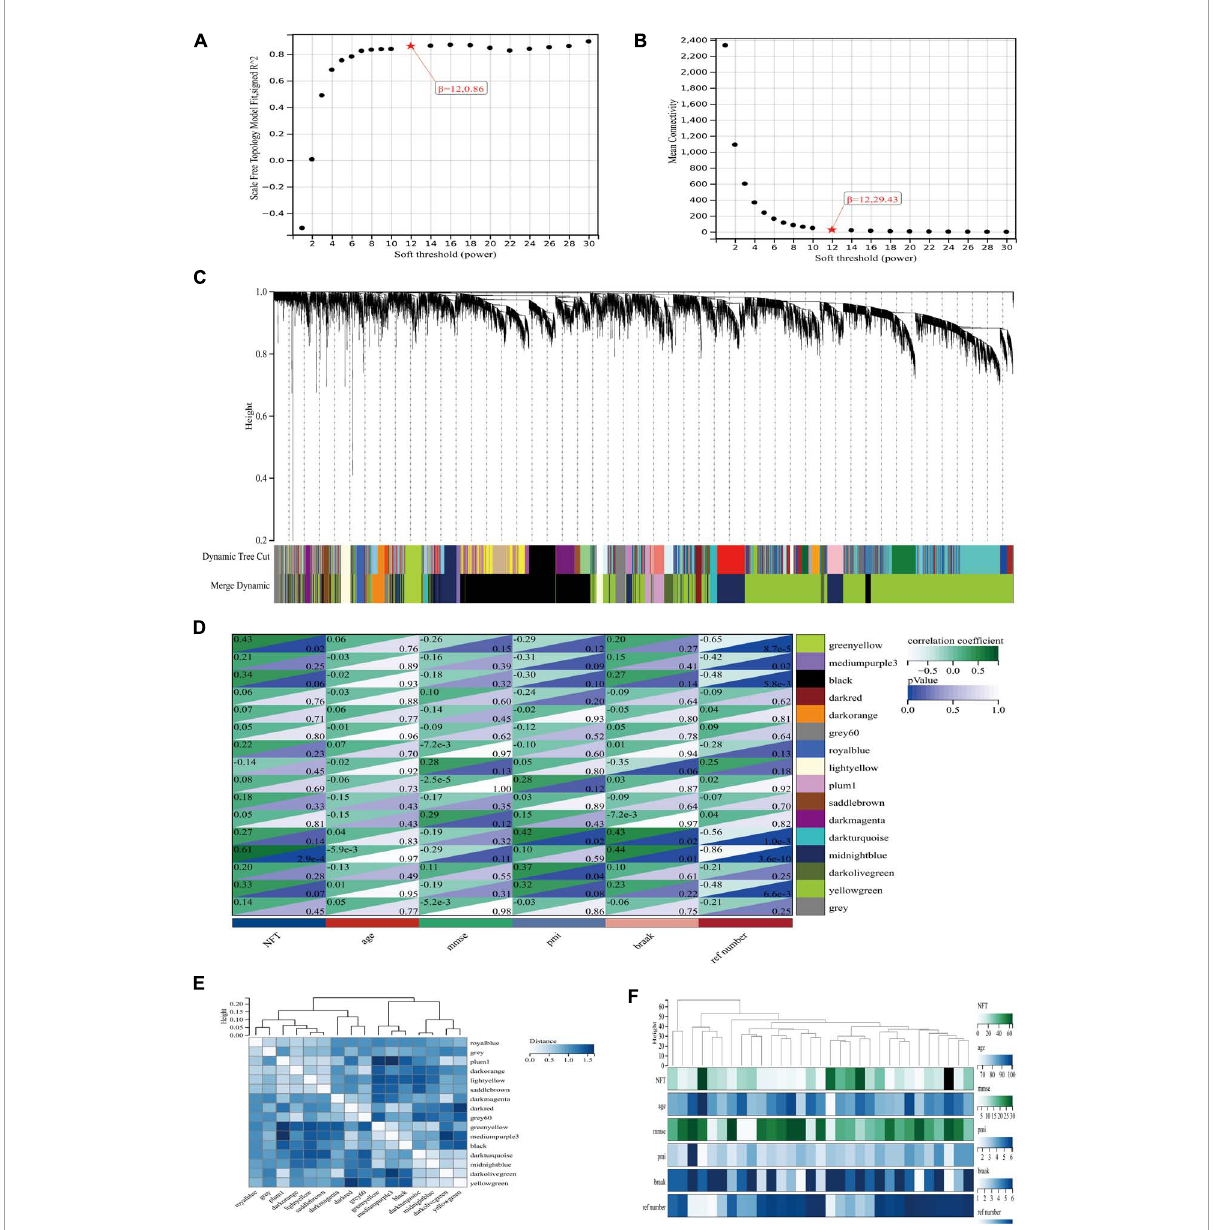
FIGURE1 Co-expression network of differentially expressed genes in AD. (A,B) Soft threshold power selection. (C) Clustering tree dendrogram of co-expression modules. Different colors represent distinct co-expression modules. (D) Correlation analysis between midnightblue module and clinical condition, each column represents one module, individual rows represent clinical status. (E) Correlation between modules. (F) Specific clinical information of the